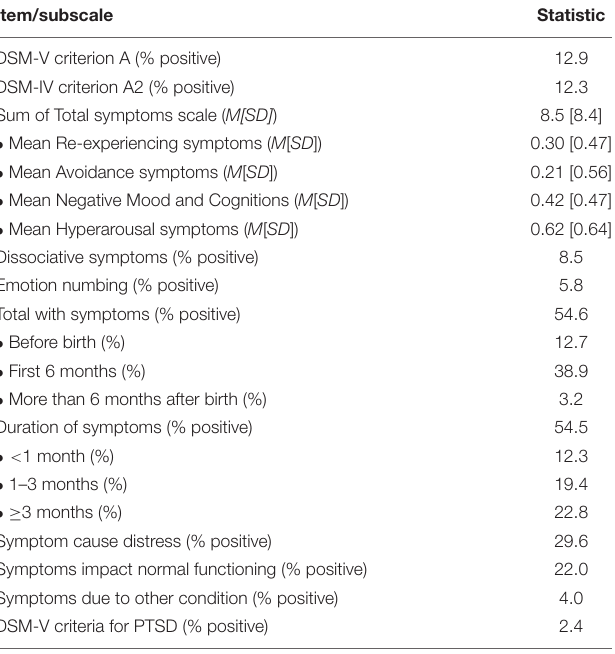
TABLE 2 | Characteristics of responses to